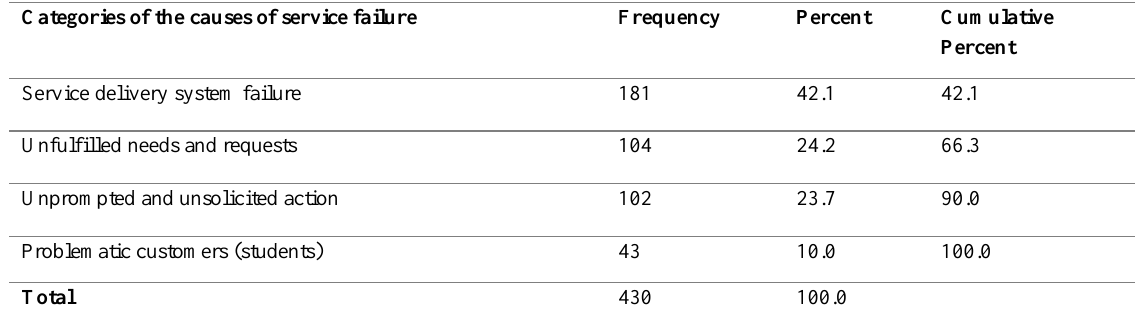
Table 1: Categories of the causes of service failure